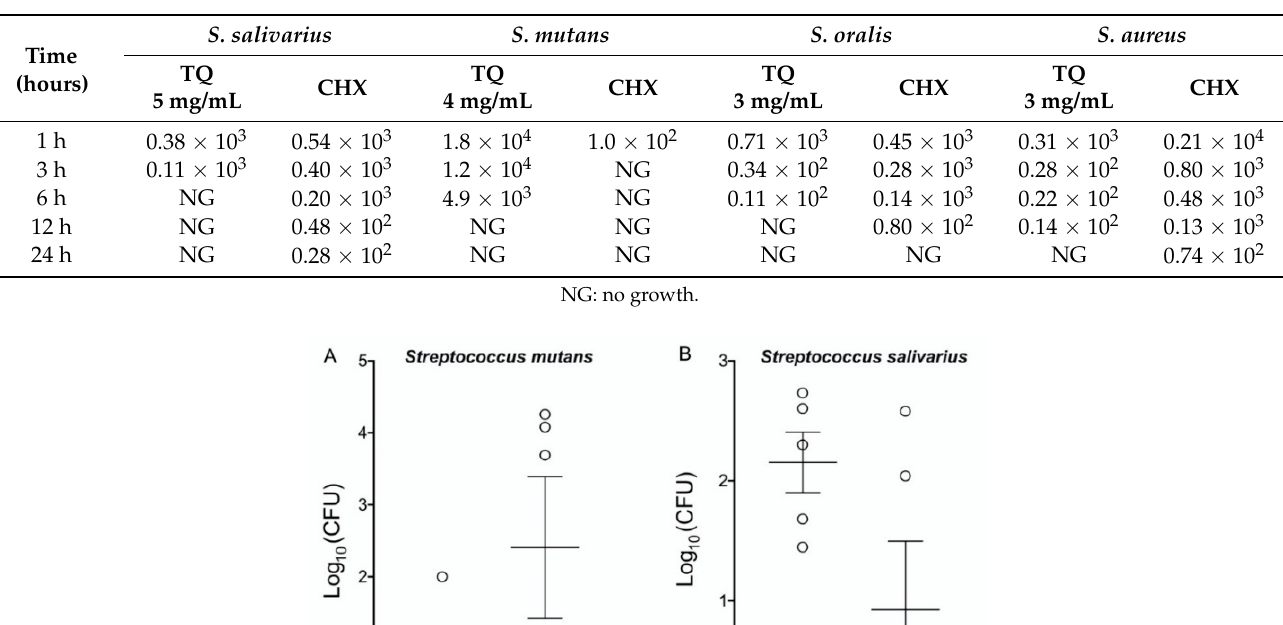
strain. The dot-plot shows the distribution of the individual measurements and the mean (horizontal line), and the standard error of the mean (capped vertical line). A statistically significant difference ( p < 0.05) is indicated with bars and an asterisk (Figure 2). Table 3. The viable count of different strains after exposure to the MBC values of TQ and positive control (CHX) during different observation periods.